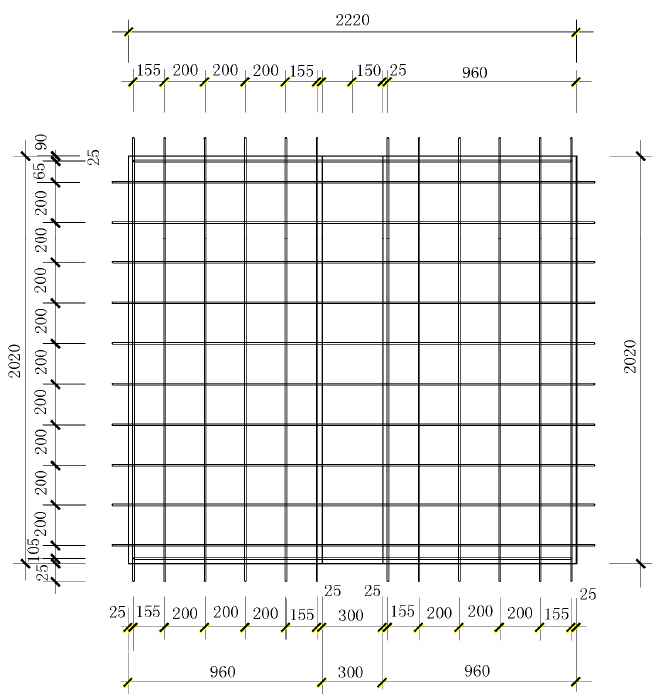
Figure 3. The reinforcement diagram of the cast-in-place layer of the specimen.